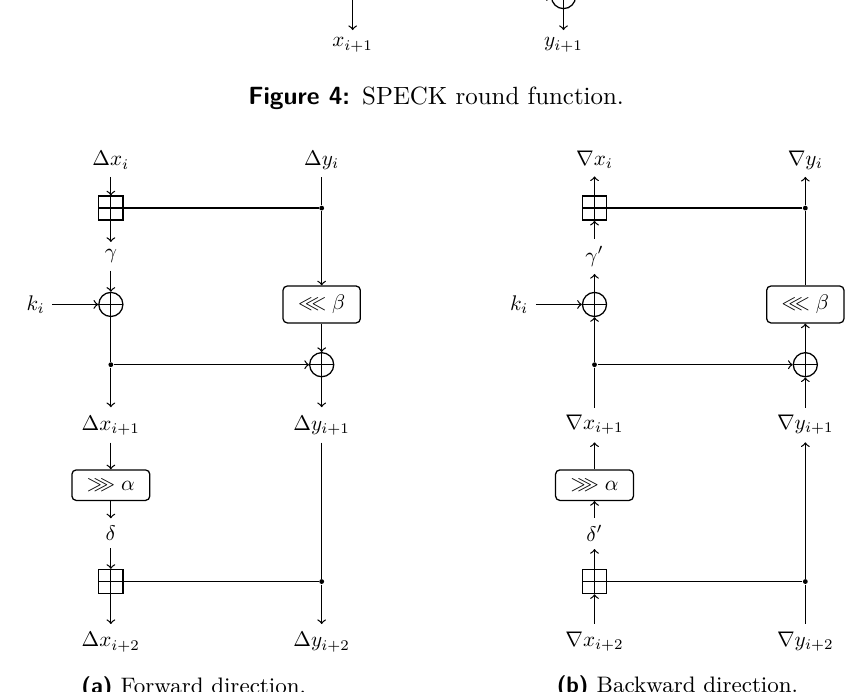
Figure 5: A 2-round switch of